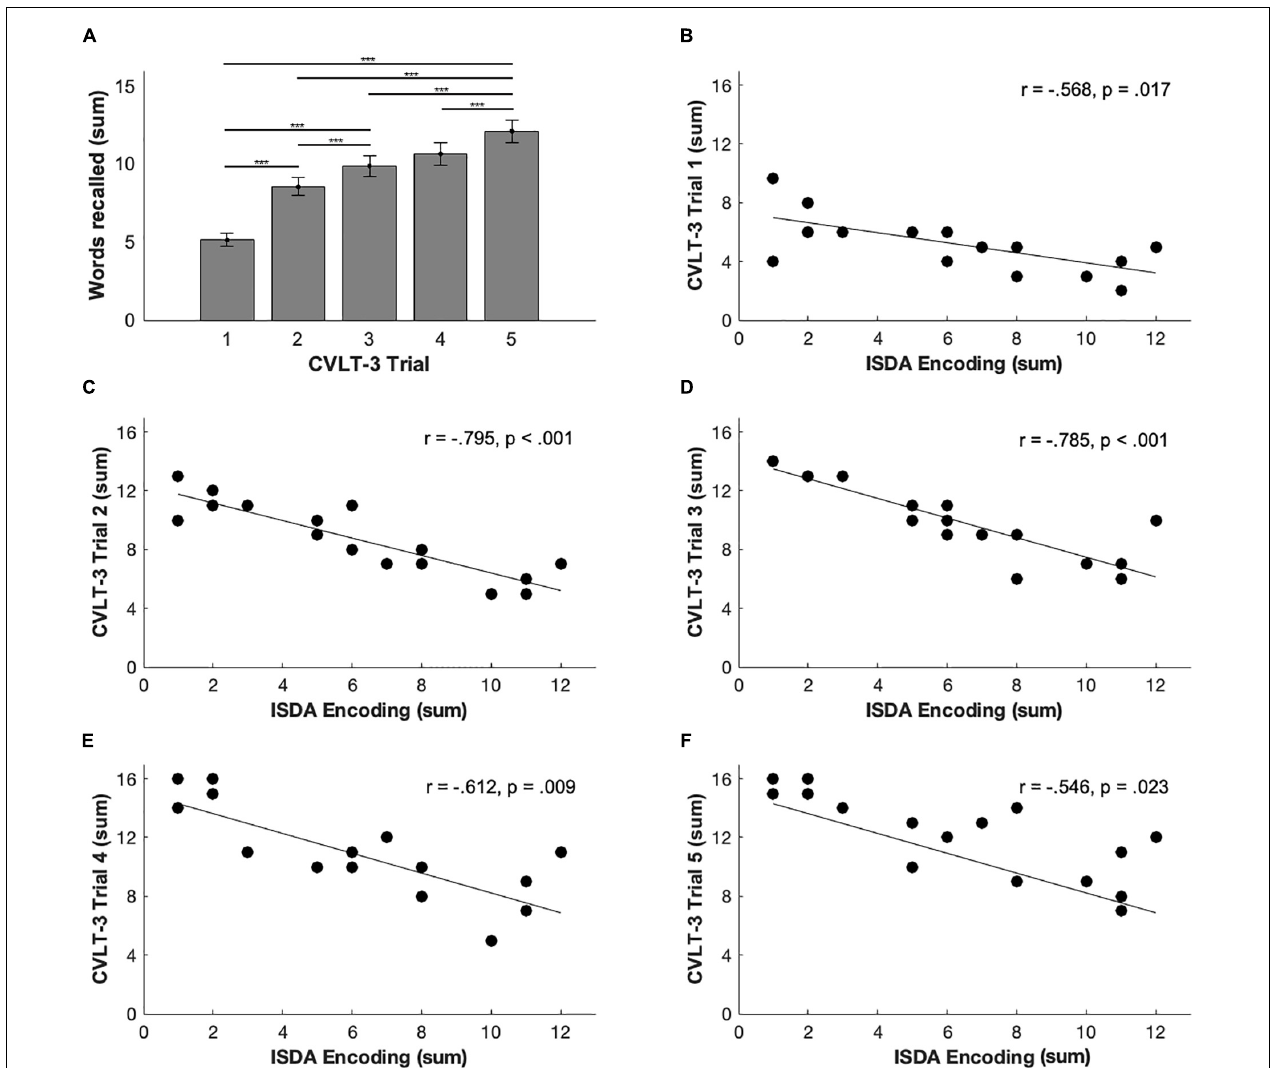
FIGURE 2 | CVLT-3 and ISDA relationships. (A) Means and SDs for all participants across trials 1–5. Significant differences were noted between all trials except for trials 3 and 4 with Bonferroni correction *** ≤ 0.001. (B–F) Correlation plots indicating the relationship between each trial and the ISDA encoding measure. Significant correlation between each of the trials 1–4 with the ISDA measures except for trial 5 which did not meet significance with Bonferroni correction; α =